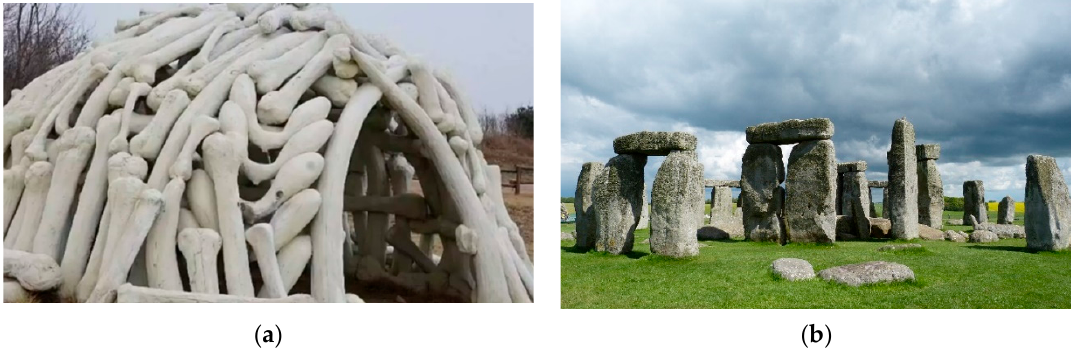
Figure 2. Examples of nearly intact structures dating back to 15,000 years ago: ( a ) dwellings of mammoth bones [source: arthistory390, Flickr.com], ( b ) megalithic monument [source: